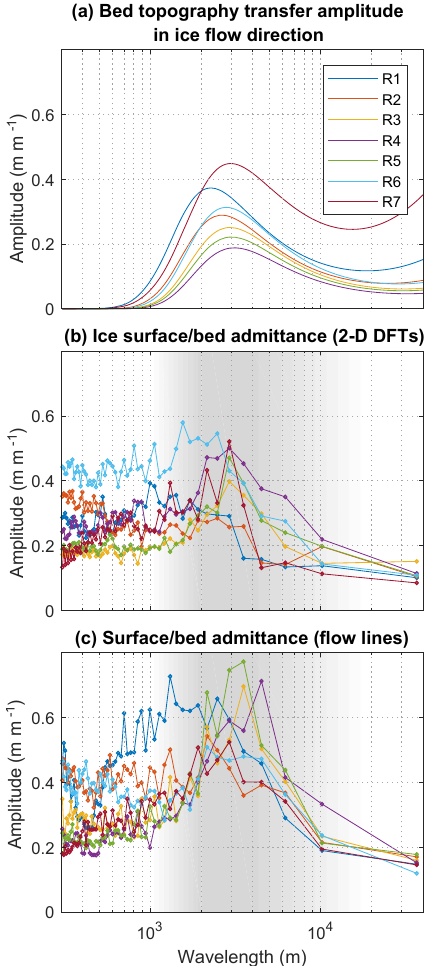
Figure 7. (a) Predicted bed topography transfer amplitudes from our seven study regions (Fig. 1a, Table 1), with η = 10 14 Pas and C 0 ∗ = 10 in all regions. (b) Results from one method for calculating empirical admittance of measured bed topography to observed ice surface topography by binning and averaging absolute wave num- ber components of 2-D DFTs (see Sect. 2.3.5). (c) Results from a second method for calculating empirical bed-to-surface admit- tance by binning and averaging 1-D DFTs from multiple ice flow line transects. For all regions both calculations of empirical admit- tance (b, c) generally match predicted transfer amplitudes (a) at wavelengths greater than ∼ 1km and exhibit similar peaks between ∼ 1 and 10km (shaded regions in b and c ). At wavelengths less than ∼ 1km both empirical admittance calculations are higher than predicted transfer